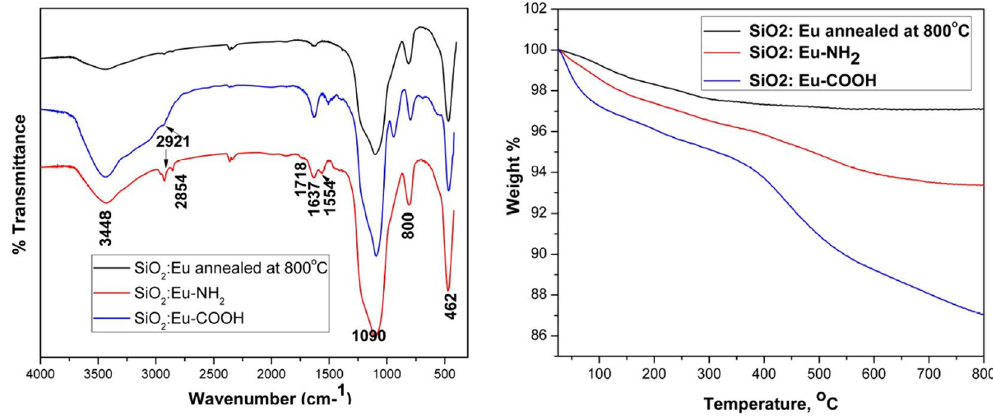
Figure 3. ( a ) FTIR spectra of annealed SiO 2 :Eu, SiO 2 :Eu-NH 2 and SiO 2 :Eu-COOH functionalised nanoparticles ( b ) TGA curves of annealed SiO 2 :Eu, SiO 2 :Eu-NH 2 and SiO 2 :Eu-COOH functionalised nanoparticles.